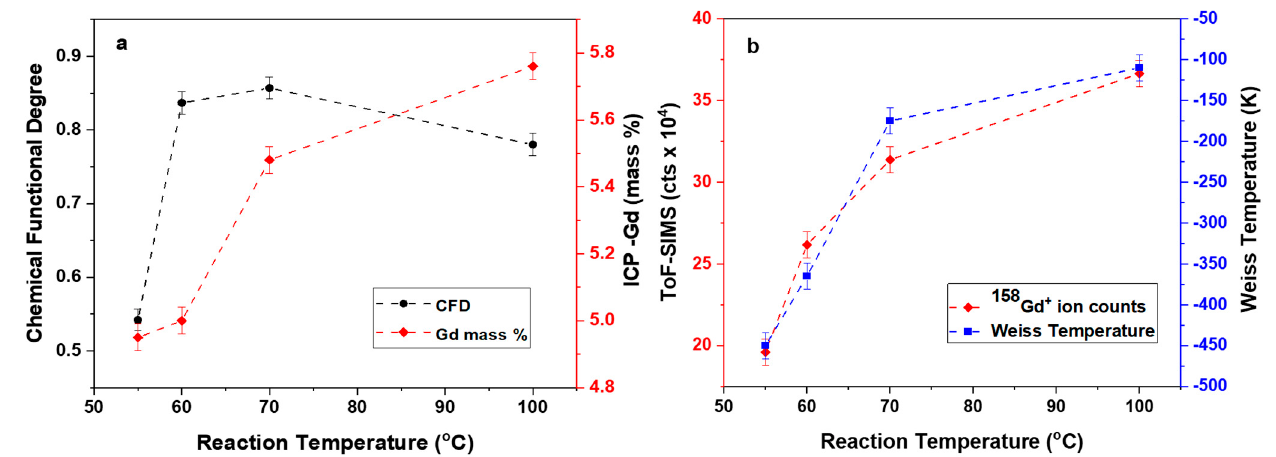
Figure 7. Tuning magnetic properties of MWNT coupled with Weiss temperature by changing functionalization degree and respective magnetic molecule loading percentage. Change in the oxidation reaction temperature of CNTs has a direct influence on their ( a ) chemical functionalization degree, ( b ) magnetic molecule (Gd-DTPA) loading percentage (ICP-AES and ToF-SIMS count) and Wiess temperature.